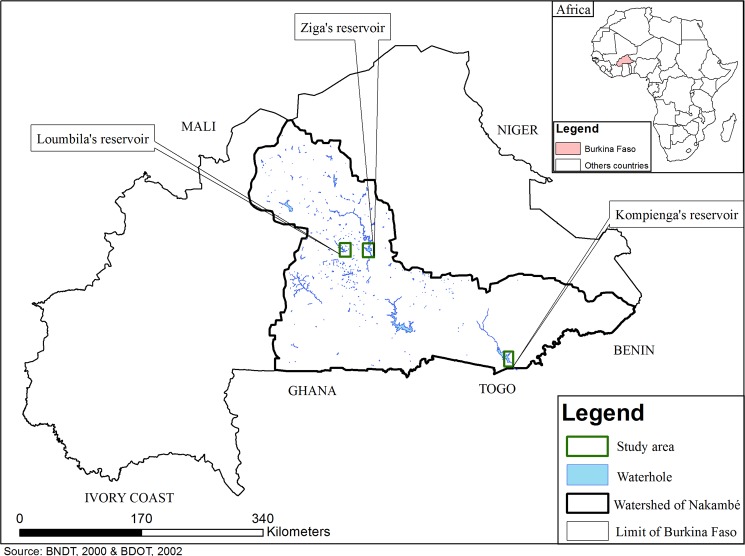
Map of study areas showing locations of the three reservoirs in Burkina Faso.Source: Base Nationale de Données Topographiques (BNDT), 2000 and Base de Données d’Occupation des Terres (BDOT), 2002 of Burkina Faso.